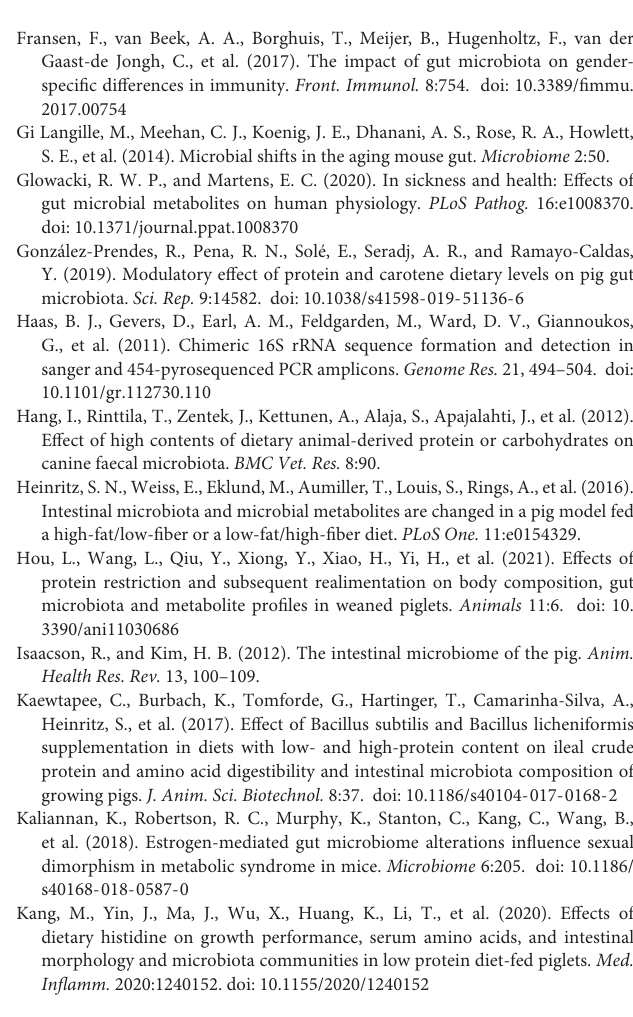
Supplementary Table 1 | The compositions and nutrition levels of the experimental diets (Dry matter basis, %). Supplementary Table 2 | Raw reads and selected effective sequences in each sample. Supplementary Table 3 | All metabolites detected for barrows and gilts fed low and high protein diets. Supplementary Table 4 | Differentially abundant metabolites between GHP and GLP. Supplementary Table 5 | All KEGG pathways enriched between GHP and GLP. Supplementary Table 6 | Comparison of the relative abundance (Top 10, %) of microbial community structure in colonic content at genus level between GHP and